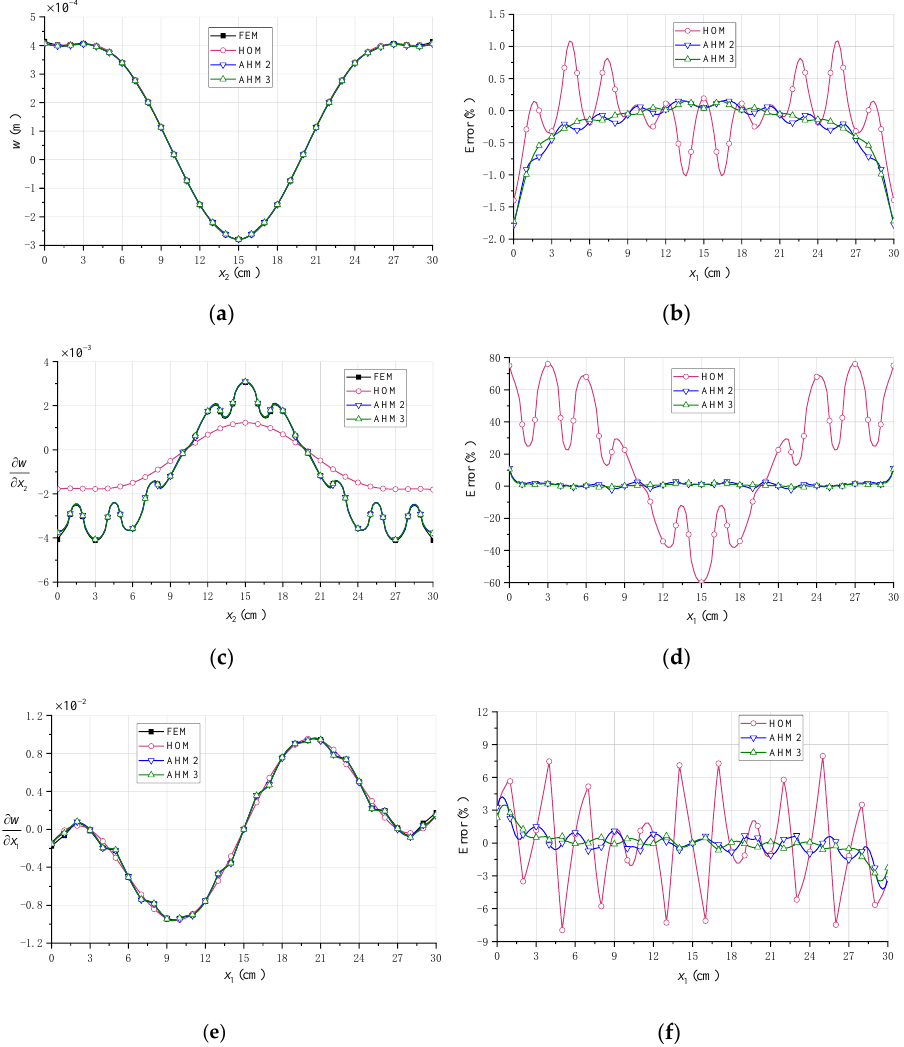
Figure 15. Deformations of the SFSF plate along Line B. ( a ) w ; ( b ) Error of w ; ( c ) 𝜕𝑤 𝜕𝑥 2 ⁄ ; ( d ) Error of 𝜕𝑤 𝜕𝑥 2 ⁄ Table 6. DRSS for the SFSF four-layer periodic